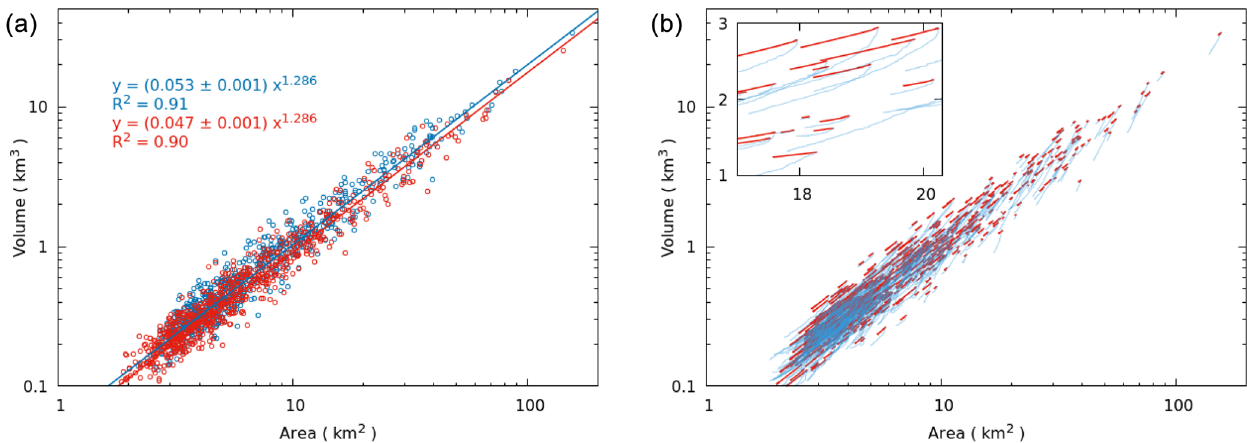
Figure 1. (a) Glacier volume as a function of area for the 703 Himalayan glaciers simulated with SIA at t = 0 years (blue circles) and at t = 500 years (red circles) is plotted along with the corresponding best-fit scaling relations (blue and red solid lines). The corresponding fitted functions and R 2 values are shown in blue and red, respectively. (b) The trajectories of the 703 glaciers in the V − A plane as simulated with SIA (thick red lines) and scaling (thin blue lines) models. The inset is a zoomed-in version of the same plot, but with a linear scale.